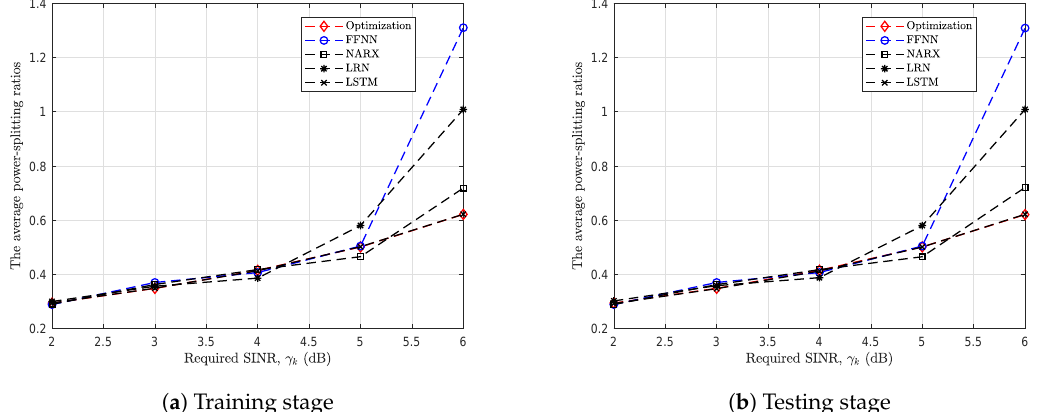
Figure 8. Average power-splitting ratios according to the required SINR when the required harvested energy is given by − 20 dBm ( e k = − 20